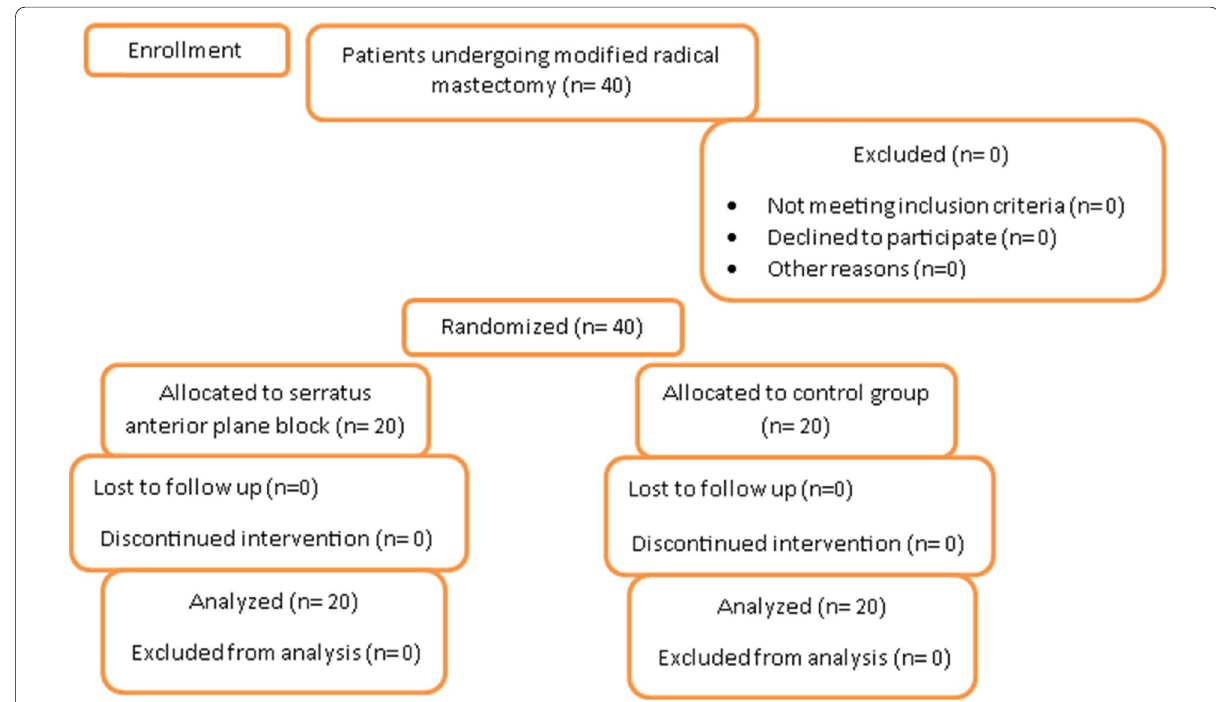
Fig. 1 Flowchart of the patients’ study design